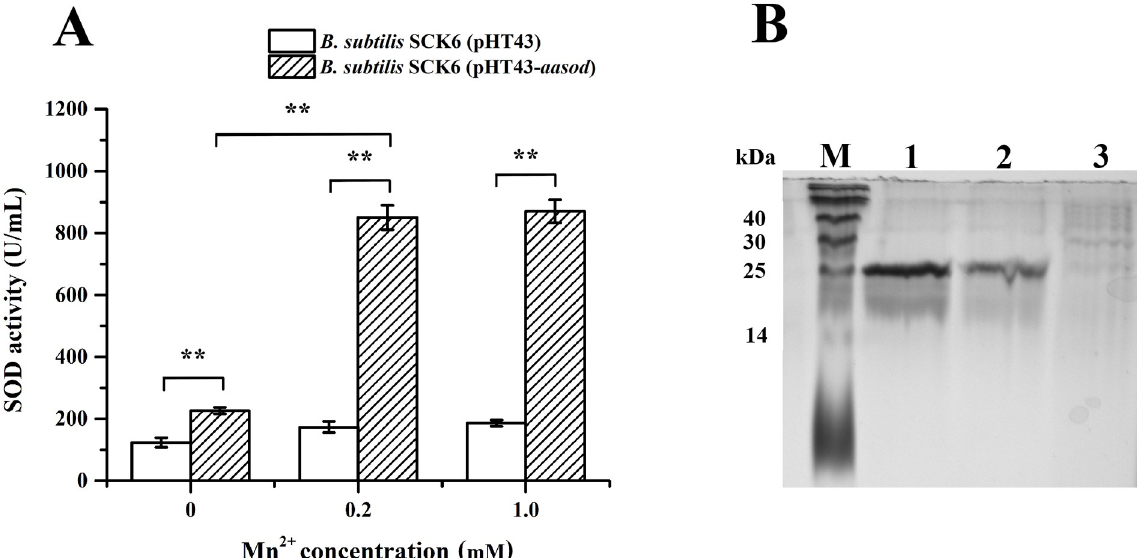
Fig 1. Heterologous expression of Aa SOD in B . subtilis . (A) Confirmation of the Mn 2+ -dependent extracellular SOD activity of recombinant B . subtilis SCK6 strain harboring pHT43- Aasod plasmid. The data are expressed as the mean ± SD of three independent experiments. �� Represents significant difference ( p < 0.01) between groups. (B) SDS-PAGE analysis of the purified recombinant Aa SOD. Lane M,